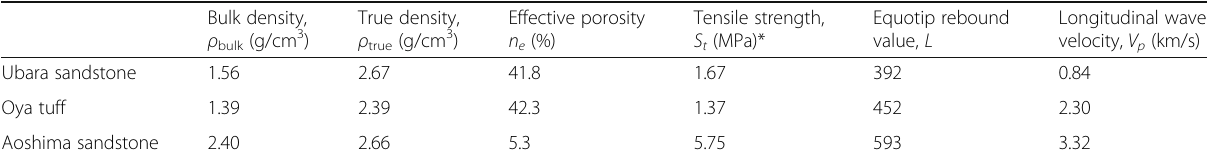
Table 1 Properties of the rocks used in experiments